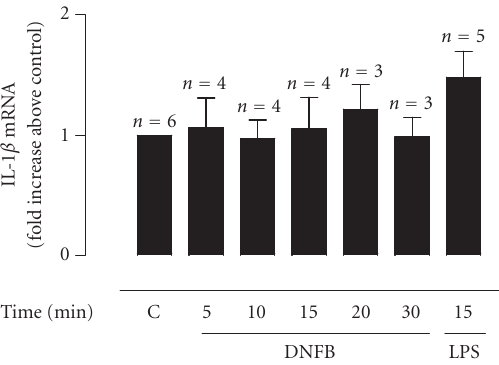
Figure 3. E ff ect of DNFB on IL-1 β mRNA in a fetal skin den- dritic cell line. Cells were stimulated with 1 µ g/mL of DNFB for the indicated periods of time. Total RNA was then extracted us- ing TRIzol Reagent, as described in “materials and methods,” and cDNA was reverse transcribed from total RNA. Quantita- tive, fluorescent PCR was performed using the TaqMan system. Relative levels of cDNA were calculated and results expressed as fold increase relatively to the control. Data are expressed as the mean ± SEM from the indicated number of experiments. Sta- tistical significance was calculated by the one-way ANOVA test with a Dunnett post-test (no significance was